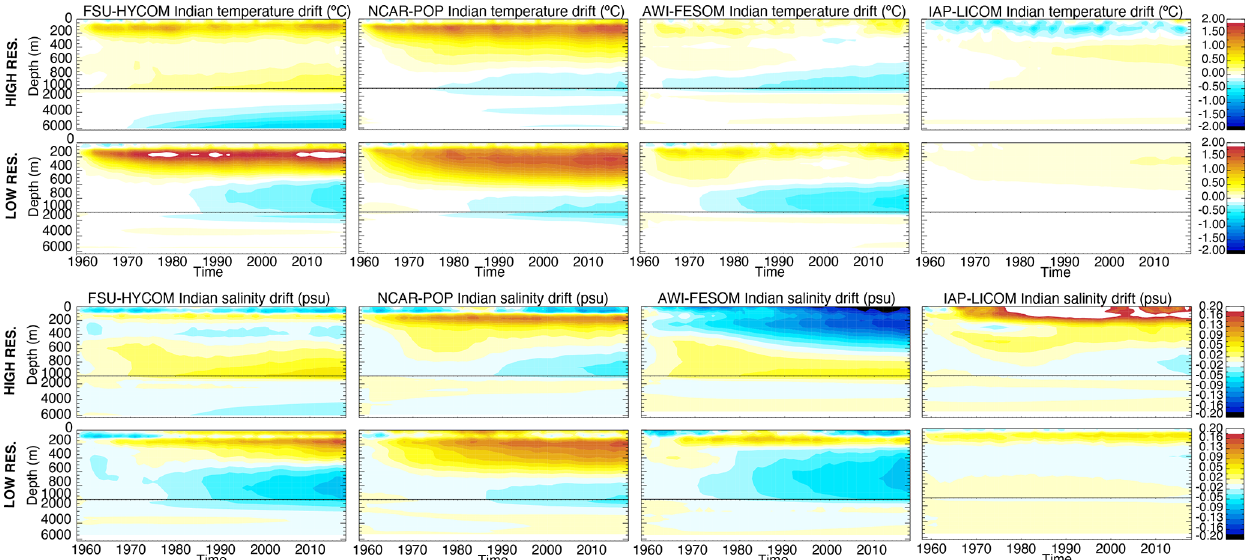
Figure 9. Time evolution of Indian Ocean temperature ( ◦ C) and salinity (psu) change (relative to initial conditions) as a function of depth for all